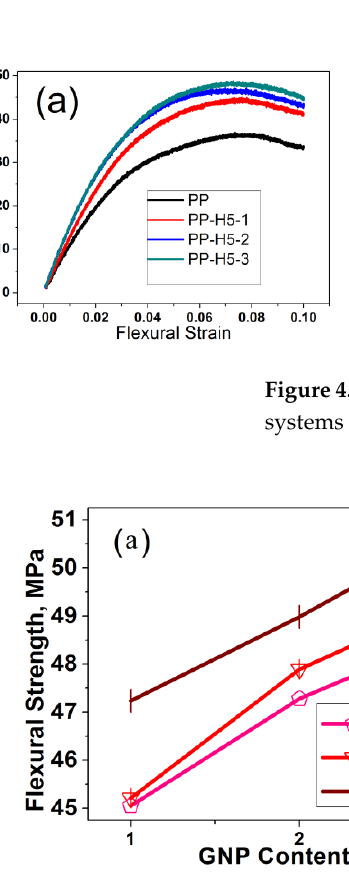
Figure 5. Dependence of ( a ) flexural strength and ( b ) flexural modulus on the wt.% and type of GNPs.